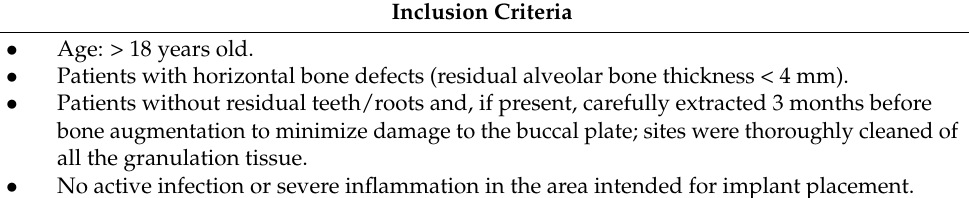
Inclusion Criteria